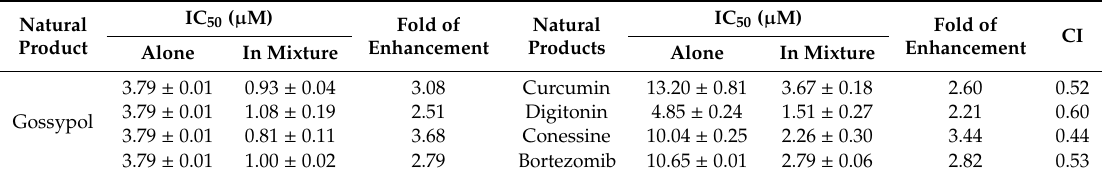
Table 3. Combinatorial e ff ects of gossypol with other natural products in inhibition of infection of ZIKV PAN2016